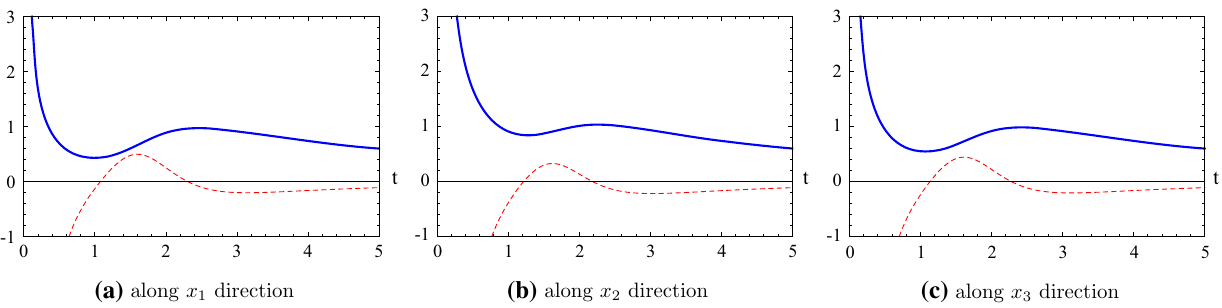
Fig. 1 The plot of m ( t ) ( solid blue line ) and n ( t ) ( dashed red line ) in different spatial coordinate directions at θ = π/ 6 ,δ 1 = − 0 . 5 ,δ 2 = 0 . 2 ,δ 3 = 0 . 4 and t 0 = 2 .